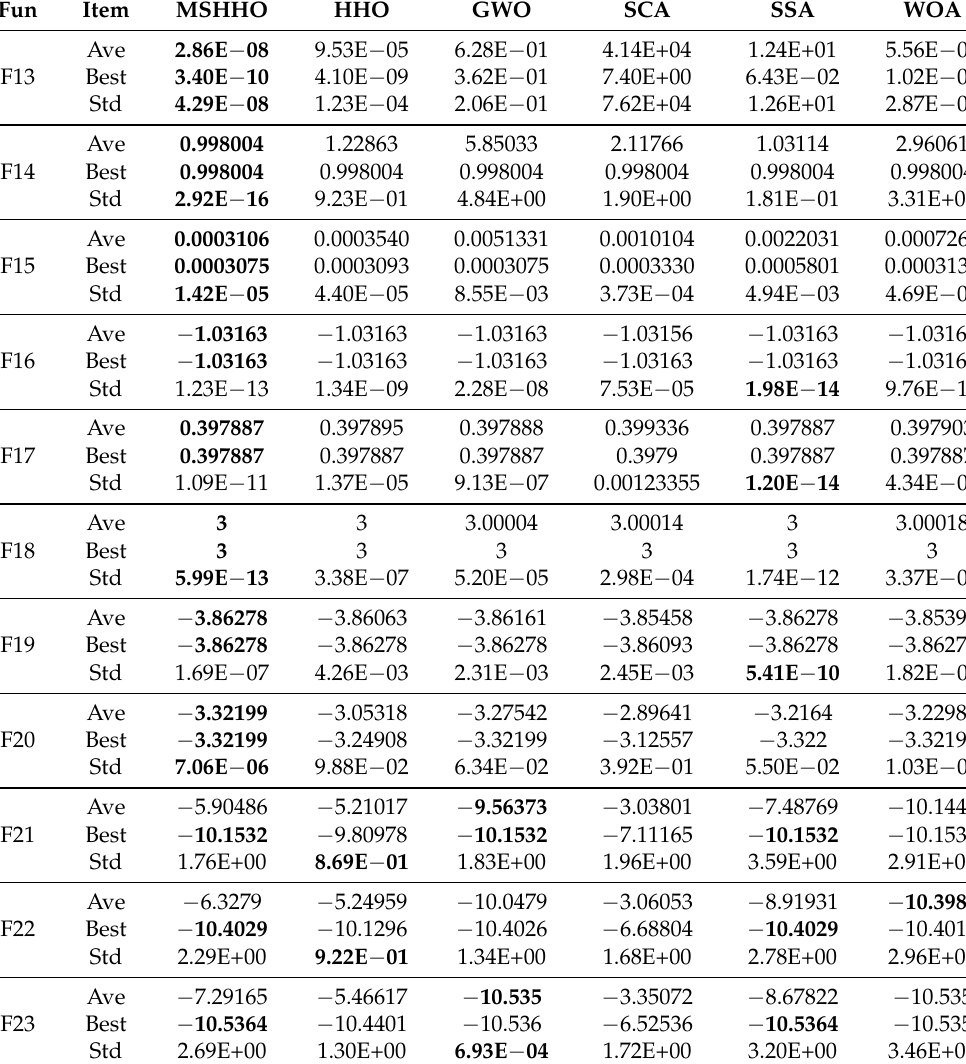
Table 3. Results of CEC2005 benchmark functions.